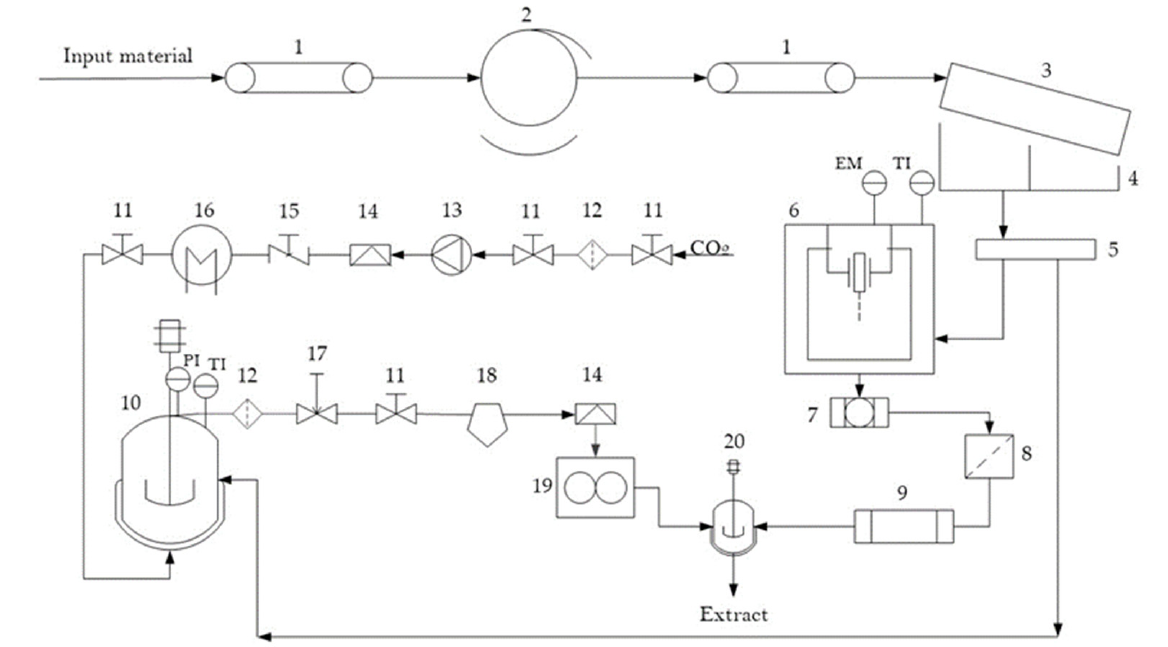
Figure 5. Simplified scheme of the process: 1: conveyor, chain, closed; 2: rotary drum; 3: sowing disc with a slope; 4: collection container; 5: bowl with stirrer; 6: ultrasonic vessel, 7: filter one; 8: filter two; 9: rotavapour; 10: autoclave; 11: valve; 12: HP filter; 13: HP pump; 14: rupture disc; 15: one-way valve; 16: heat exchanger; 17: regulating valve; 18: separator; 19: flowmeter; 20: mixer.